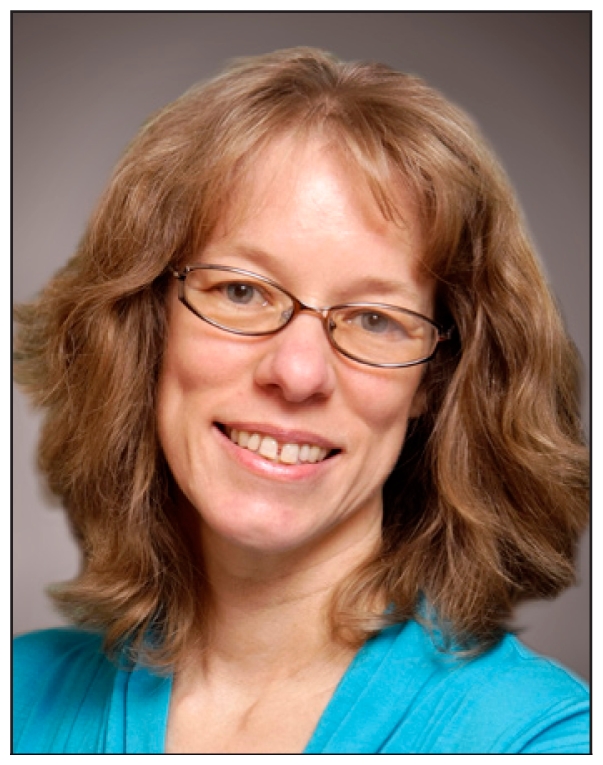
Jane C. Schroeder